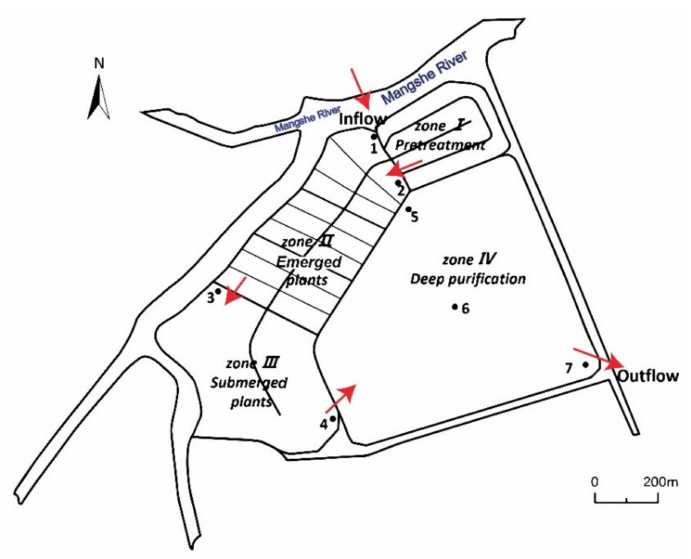
Figure 1. Sampling sites in the Yanlonghu CW-R. Seven sampling transects corresponded with the water flow direction. Note: S1 was at the inlet of the whole system; S2 was at the outflow of zone I; S3 was at the outflow of zone II; S4 was at the outflow of zone III, and S5, S6, and S7 were at the inlet, center, and outlet of zone IV, respectively. Red arrows indicate the water flow along the four